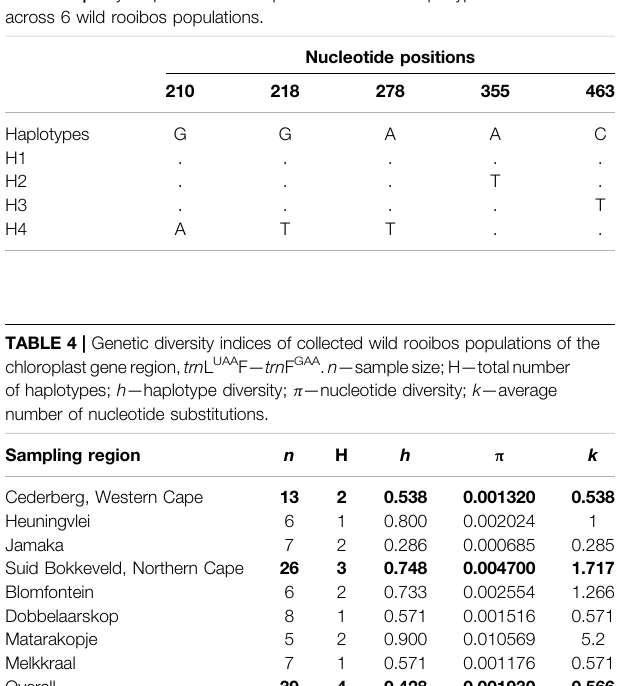
TABLE 3 | Polymorphic nucleotide positions of the 4 haplotypes determined across 6 wild rooibos populations. Nucleotide positions